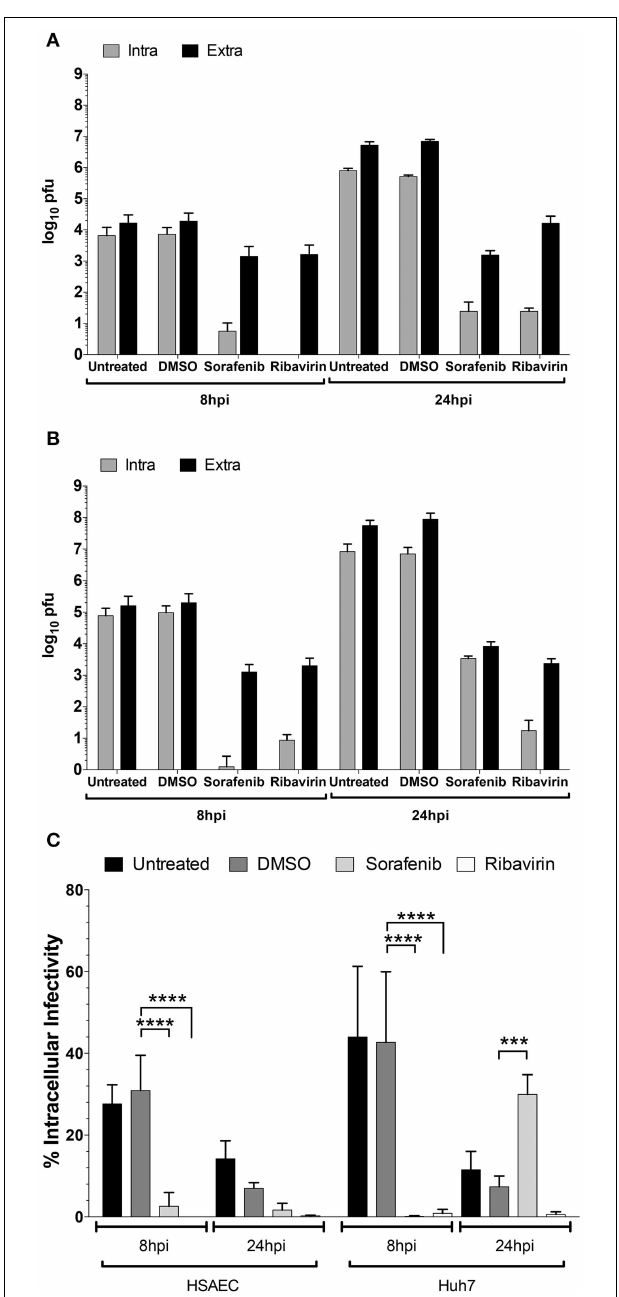
FIGURE 5 | Increase in rMP12 intracellular infectivity after sorafenib treatment. (A) HSAECs and (B) Huh7 cells infected with rMP12 (MOI 0.1) were either left untreated, or treated with DMSO, 10 µ M sorafenib, or 82 µ M ribavirin as described previously. Intra- and extracellular infectivity per infection as determined by plaque assay is plotted. (C) Total infectivity (i.e., sum of intra- and extracellular infectivity) per infection was determined. The percentage of intracellular infectivity relative to the total was plotted for all conditions. Means and standard deviations for four biological replicates are plotted. Two Way ANOVA comparing conditions within each cell background was performed utilizing the Holm-Sidak correction for multiple comparisons. Those comparisons that demonstrated significant differences between DMSO and the other conditions at their respective timepoints are shown. *** p ≤ 0 . 001 , **** p ≤ 0 . 0001